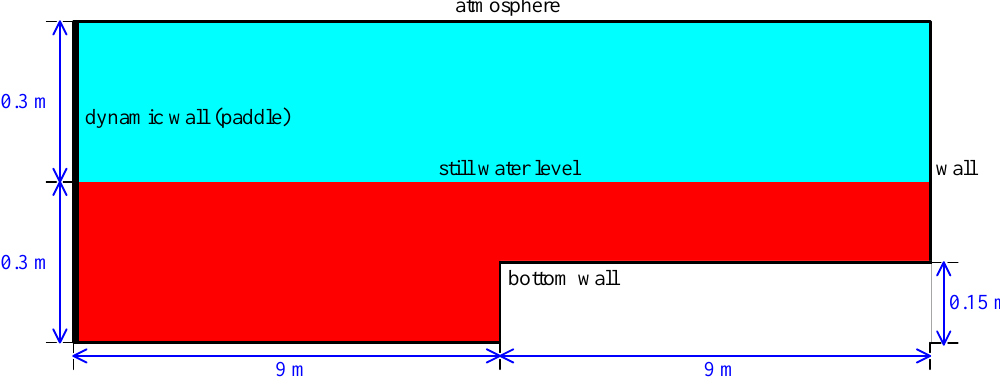
Figure 10. The overflow of the water through the gap between the paddle and a side wall of the wave flume.